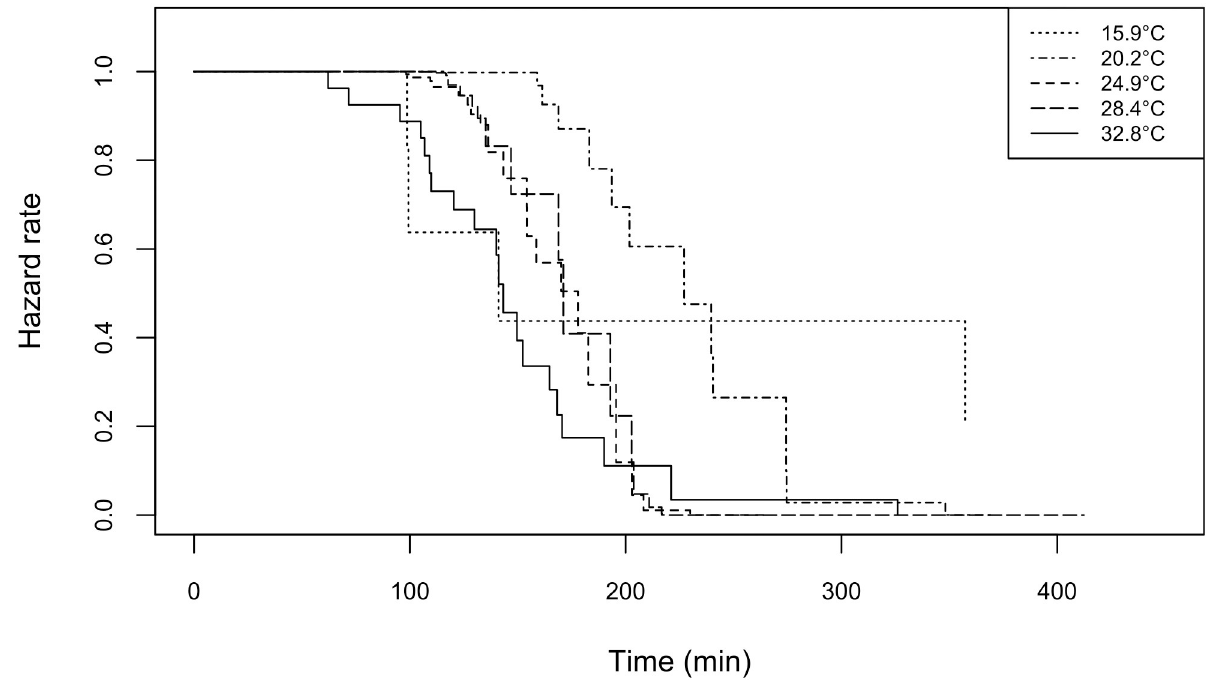
Fig 3. Patch-leaving hazard rate of Anaphes listronoti females when exploiting Listronotus oregonensis egg masses at different temperatures.